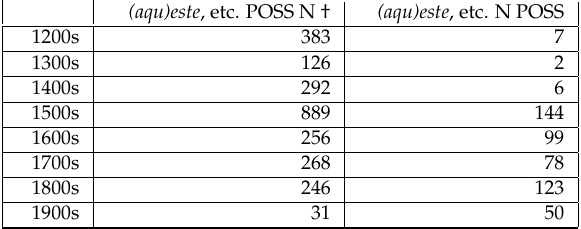
Table 13. Demonstrative + POSS + N in CdE (raw occurrences).